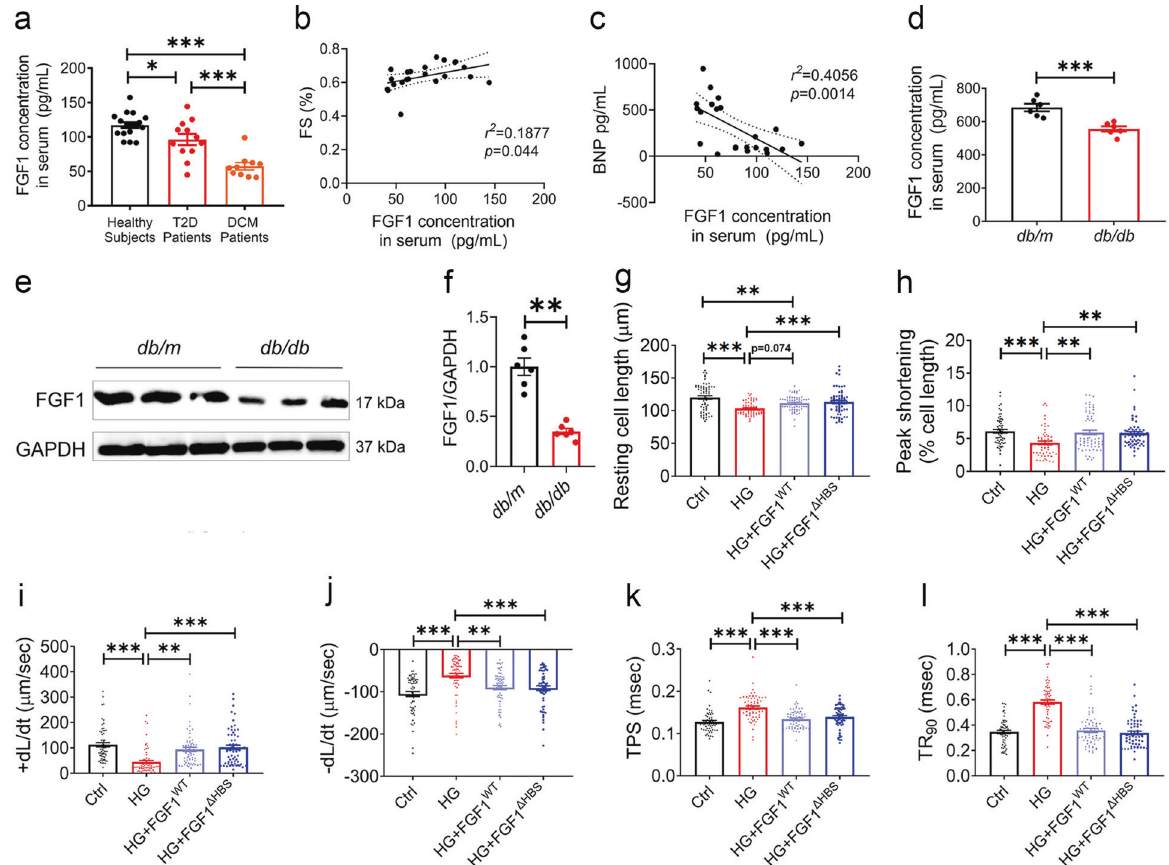
Fig. 1 Decreased endogenous FGF1 levels in diabetic individuals and comparably protective function of FGF1 WT and FGF1 Δ HBS in high- glucose-treated cardiomyocytes. a Serum levels of FGF1 in healthy subjects ( n = 17), T2D patients with ( n = 10) and without ( n = 12) DCM. b Correlation between serum FGF1 levels and fractional shortening (FS) in T2D patients. c Correlation between serum FGF1 and BNP levels in T2D patients. d Serum FGF1 levels in db/m (Ctrl) and db/db (T2D) mice determined by ELISA. n = 6. e Representative western blot analysis of FGF1 in cardiac tissues from db/m and db/db mice. GAPDH was a loading control. f Densitometric quanti fi cation of western blots as shown in e . n = 6. g – l Contractile properties of primary cardiomyocytes from adult C57Bl/6J mice were treated with FGF1 WT or FGF1 Δ HBS (500 ng/mL for 1 h) and exposed to high glucose (HG, 35 mM) for 5 h. n = 62 – 65. g Resting cell length. h Peak shortening normalized to resting cell length. i Maximal velocity of shortening ( + d L /d t ). j Maximal velocity of re-lengthening ( − d L /d t ). k Time to peak shortening. l Time to 90% re- lengthening. Data were mean ± SEM; * P < 0.05, ** P < 0.01, *** P <